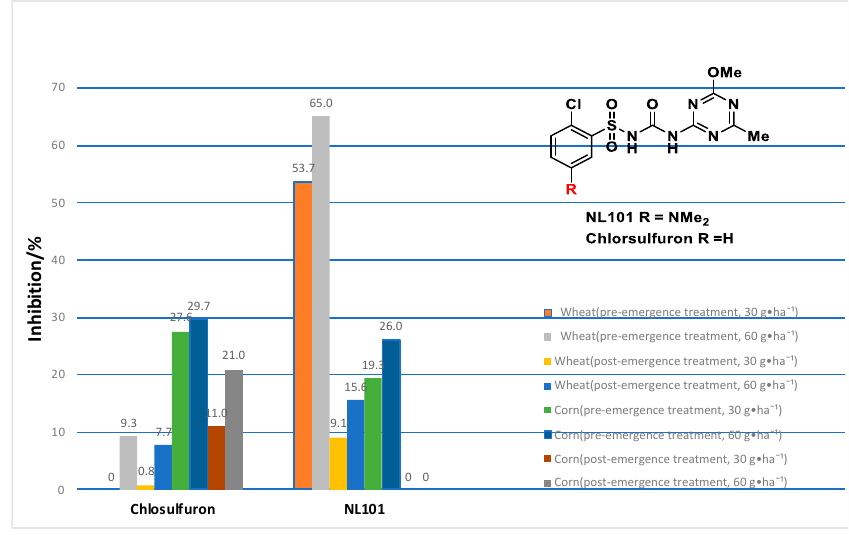
Figure 5. Crop safety of NL101 on wheat (Jima 22) and corn (Xindan 66).